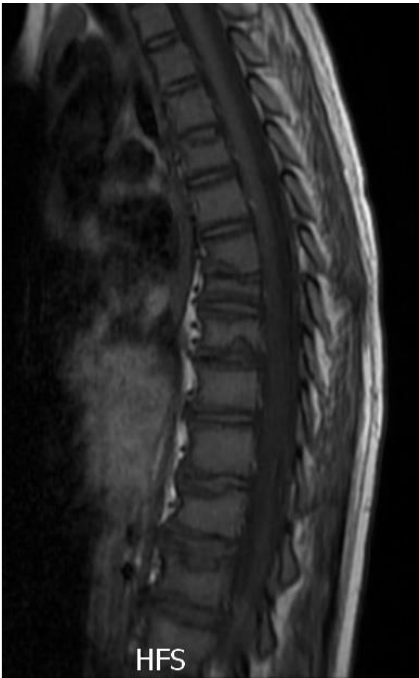
Figure 4. MRI of the spine after 1 year of pamidronate therapy (4th pamidronate cycle).